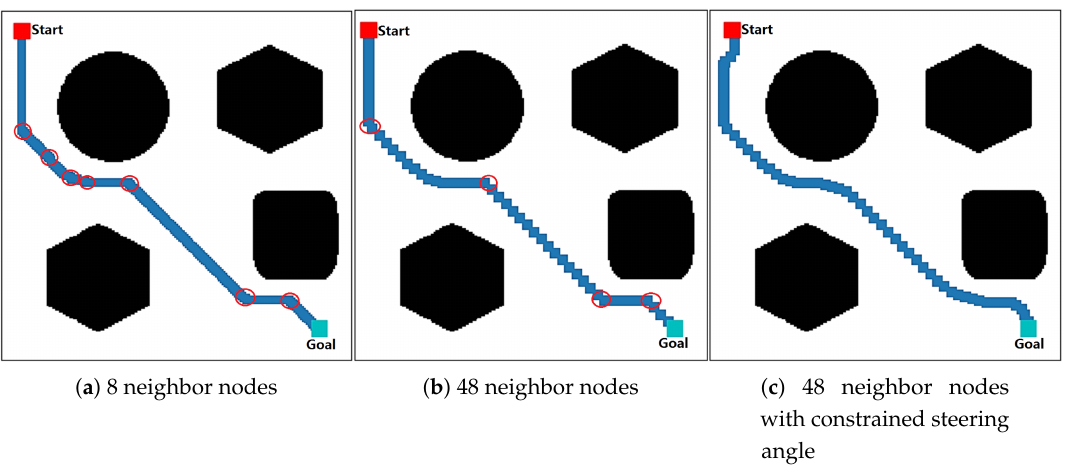
Figure 9. Path planning on 200 × 200 map.